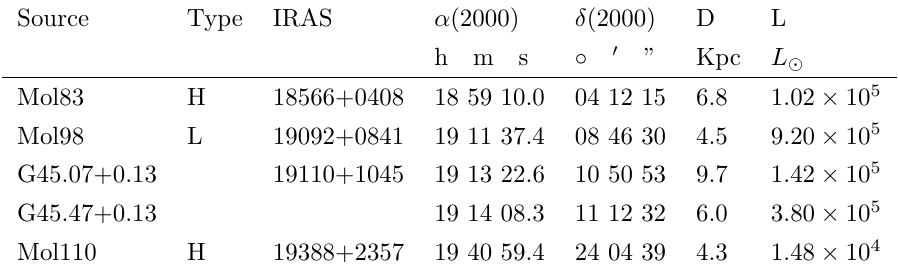
Table 1: Sample of the observed high-mass